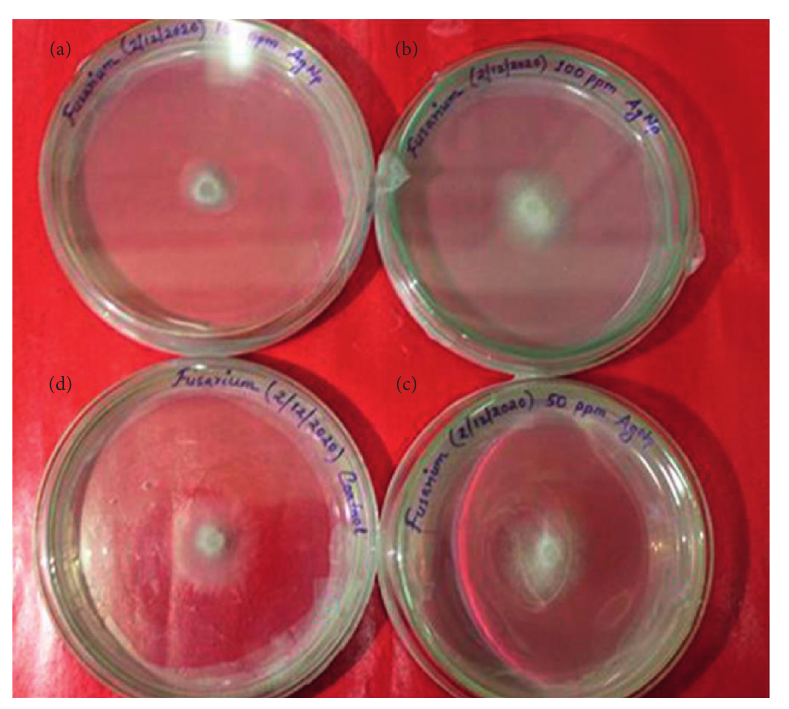
Figure 8: Antifungal bioassay of AgNPs against Fusarium oxysporum by the poisoned food technique. (a) 150ppm. (b) 100ppm. (c) 50ppm. (d) Control. The observation was recorded after 3 days of